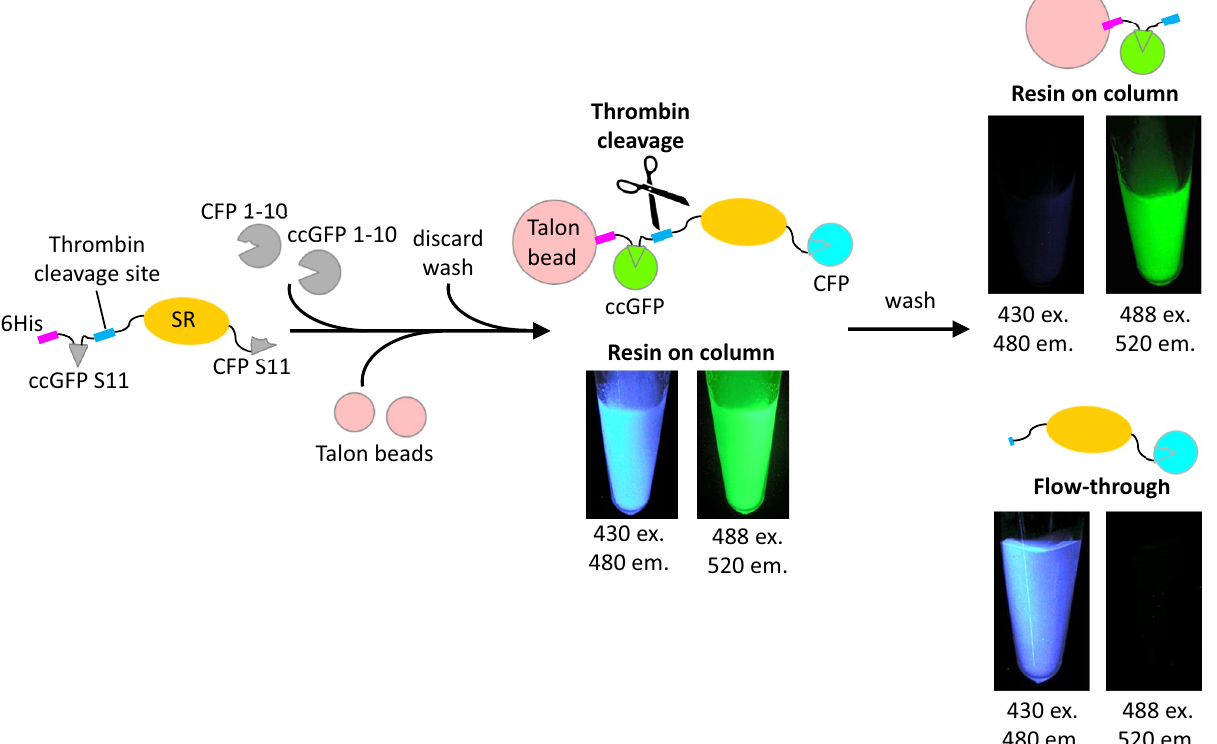
Figure 6. Double-labeling experiment with split CFP 22 and ccGFP (this work). Sulfite reductase with an N-terminal 6HIS and ccGFP S11 v1 tag, and a C-terminal CFP S11 M3 tag was complemented with an excess of CFP 1–10 OPT and ccGFP 1–10 v2 (left). Talon metal affinity beads were added to capture the complex, washed and the beads imaged to show CFP and GFP bound (middle). After cleavage of the protein on the beads by added thrombin, the beads were washed and the resin and flow through imaged to reveal where the CFP and GFP localized (right). As expected, the ccGFP was retained on the beads (upper right), while the CFP was found in the flow-through (lower